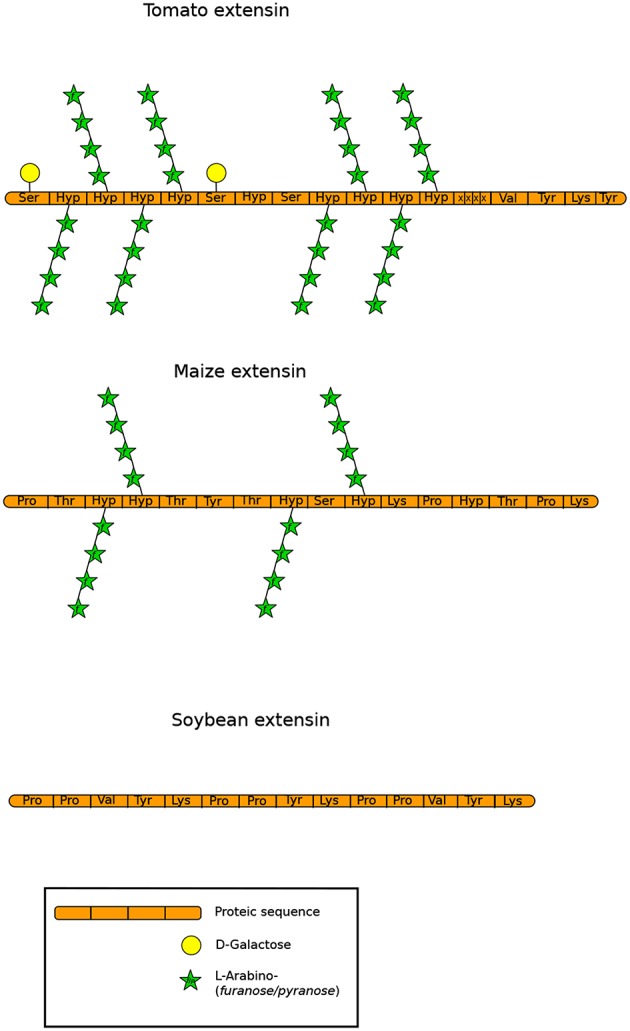
Structures of extensins described by Carpita et al. (2015) and Showalter and Basu (2016) showing different levels of O-glycosylation. Monosaccharides are represented according to the SNFG (Varki et al., 2015).